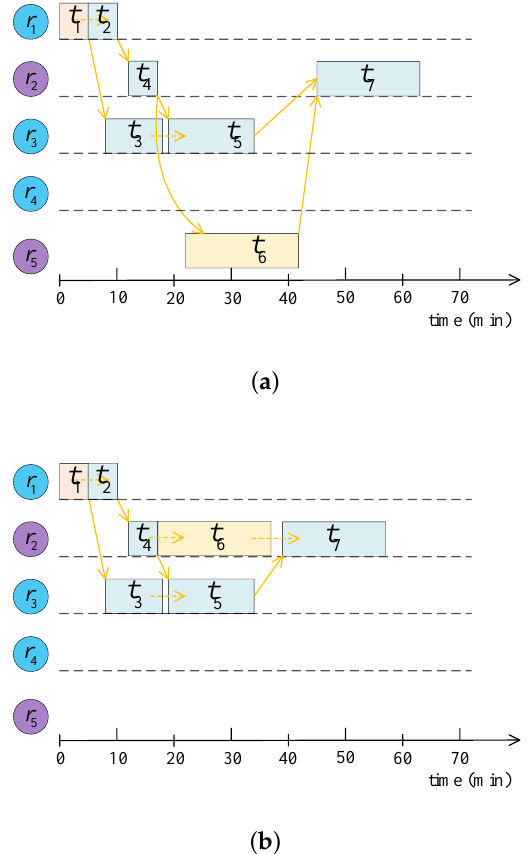
Figure 4. Example of adjusting critical tasks. ( a ) schedule result of adjusting task t 1 from resource r 2 to r 1 ; ( b ) schedule result of adjusting task t 6 from resource r 5 to r 2